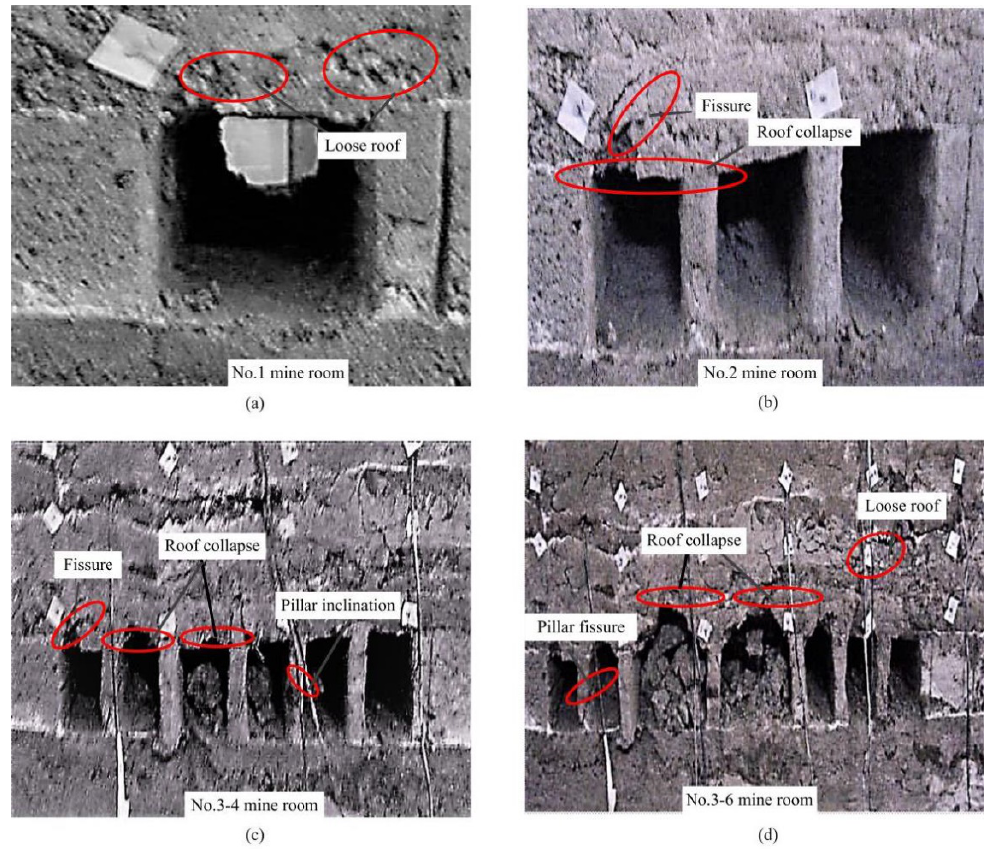
Fig. 6 Deformation and Failure Characteristics of the Roof for the 5-m Ore